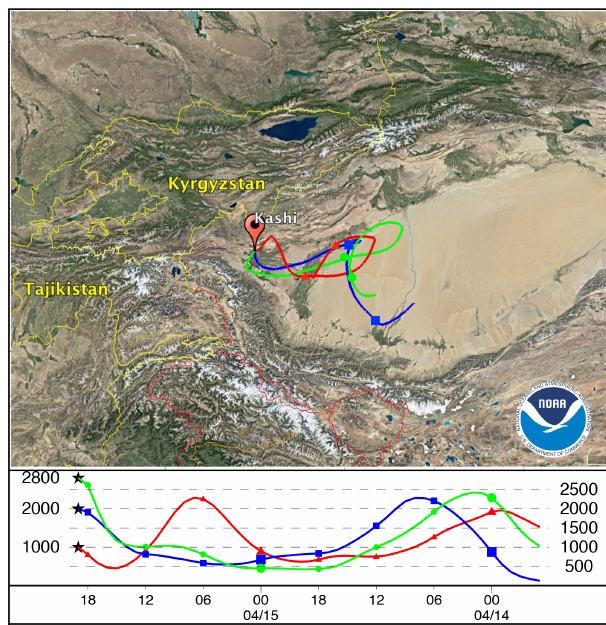
Figure 11. Case 3: the 48h back trajectories ending at 19:00UTC, 15 April 2019, for air masses at 1000, 2000 and 2800m. © Google Maps 2020.